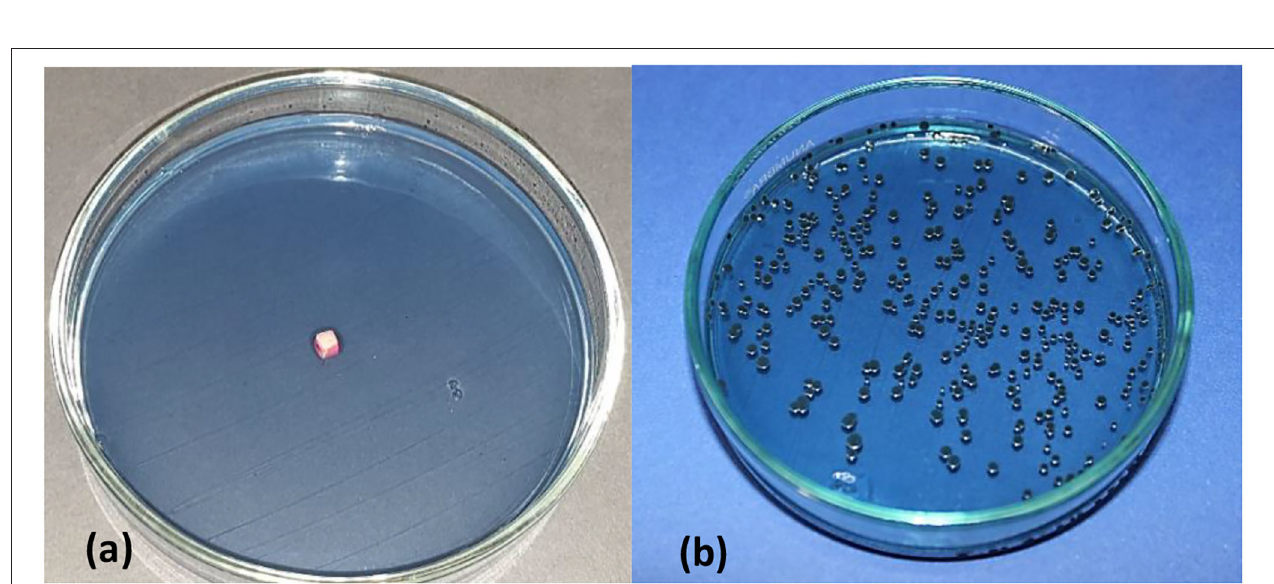
Frontiers in Dental Medicine |